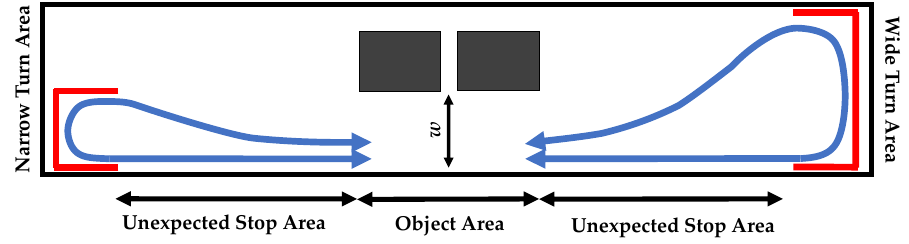
Figure 1. Experiment layout. Number of obstacles in the object area varied between 0, 1 and 2. The width of walking path in the object area ( w ) varied between 150% and 100% of shoulder width of